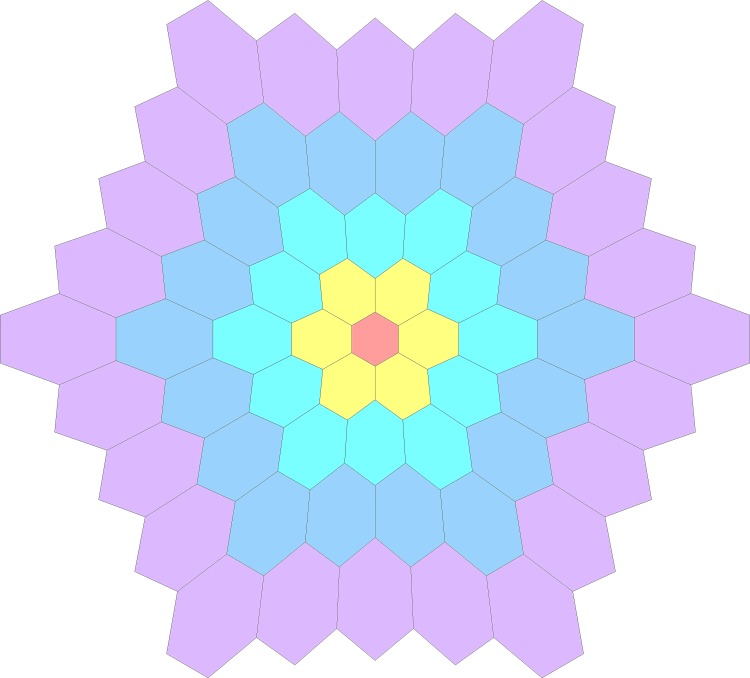
The 61-hexagonal mfERG stimulus pattern which was divided into five rings for data analysis.